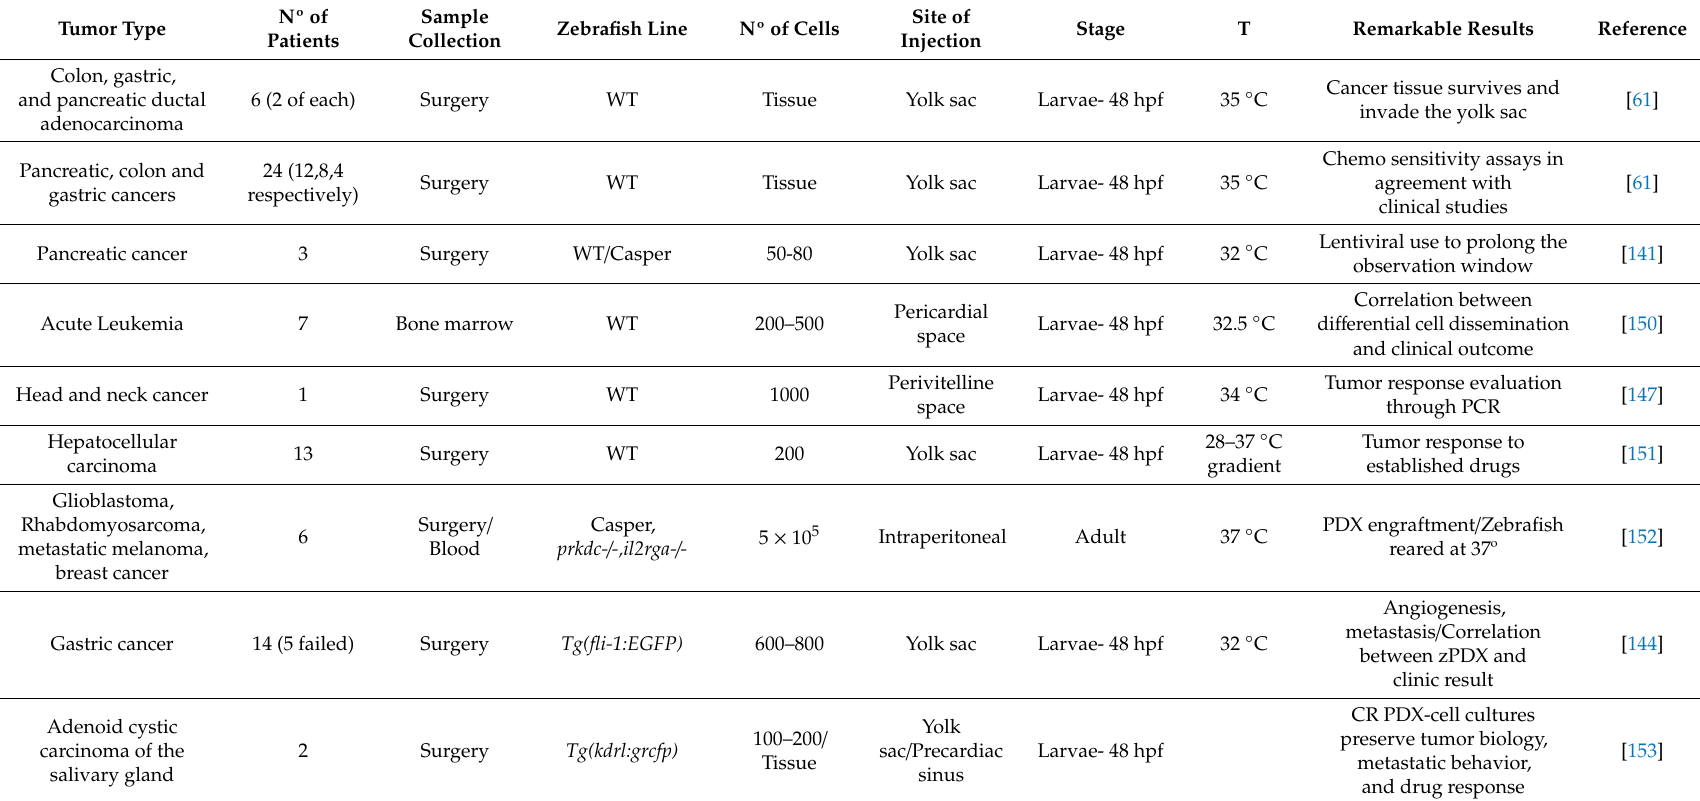
Table 2. Notable zebrafish patient-derived tumor xenograft (zPDX)